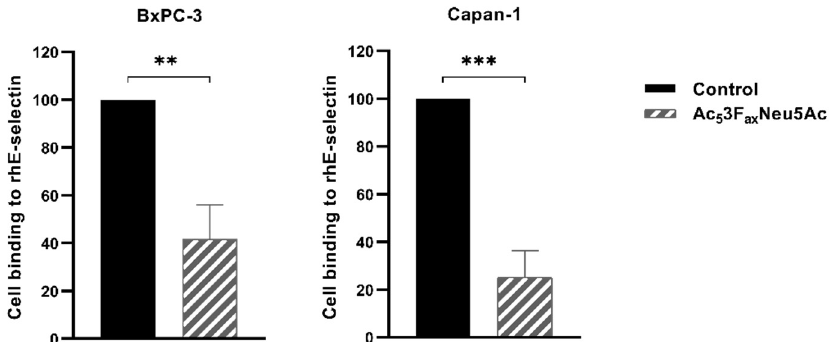
Figure 2. Ac 5 3F ax Neu5Ac treatment impaired cell adhesion to rhE-selectin in BxPC-3 and Capan-1 cells. BxPC-3 ( left ) and Capan-1 ( right ) cell adhesion was quantified after 1 h 30 min incubation over rh-E-selectin-Fc Chimera coated 96-well plates (previously treated with Fc secondary antibody) with MTS-based colorimetric assay. Plots represent mean ± SD of adherent cells normalized to non-treated (control) cells of at least three independent experiments. Unpaired Student t-test was performed ** p < 0.01 and *** p < 0.001.